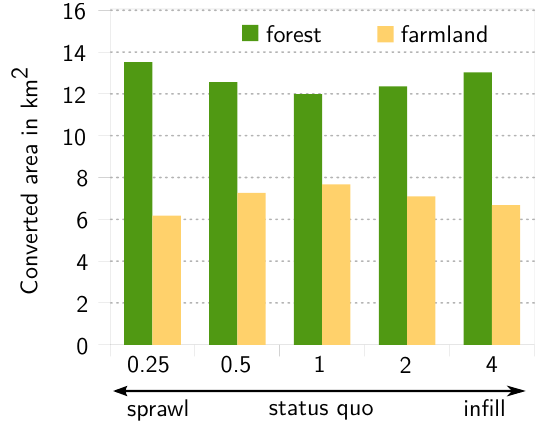
Figure 6: Area in km 2 of converted land from forest (green) and farmland (yellow) to urban differs for urban sprawl and infill scenarios. Numbers 0 . 25 to 4 represent the exponent x which transforms development probability p to p x